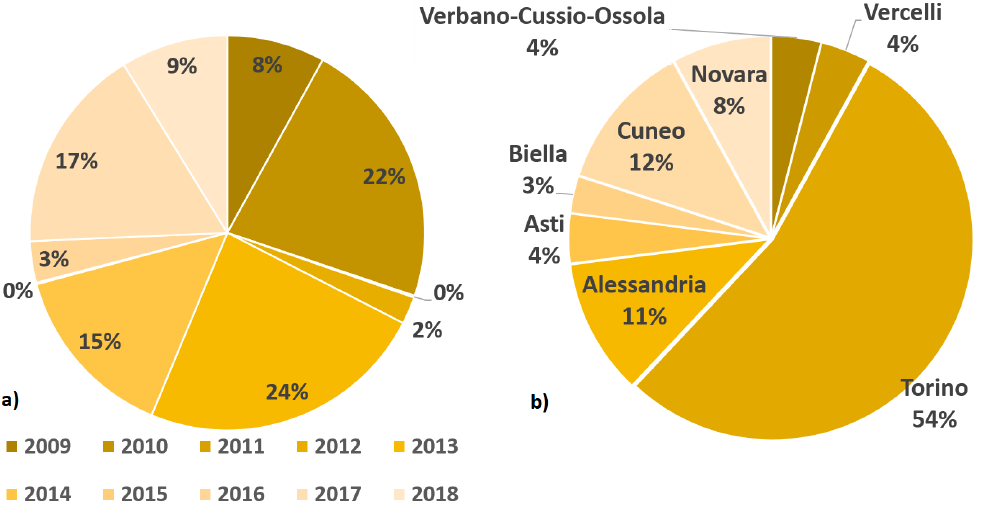
Figure 4. Basic statistic distributions considering before data